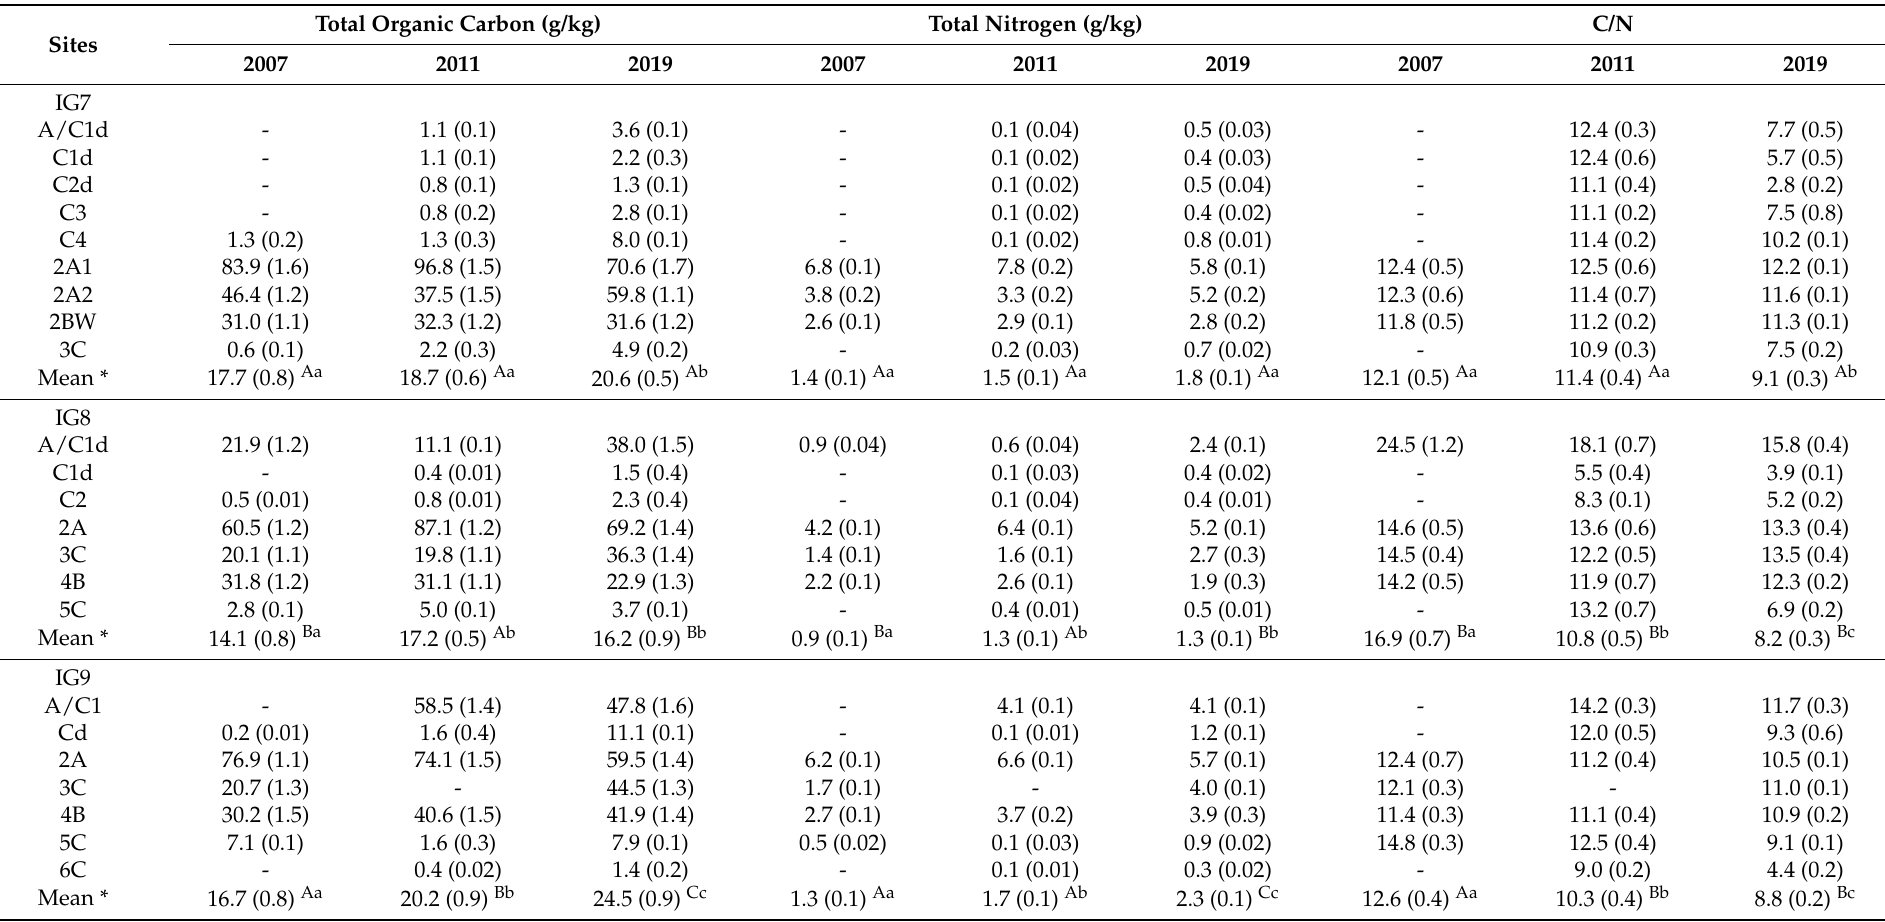
Table 4. Total organic carbon, total nitrogen, and C/N at different sites (means and standard